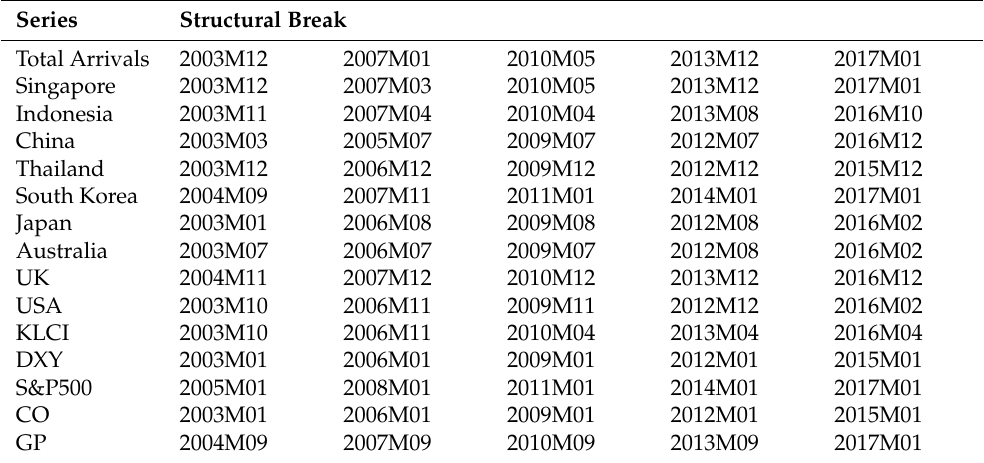
Table 3. Break points in Malaysia tourist arrivals time